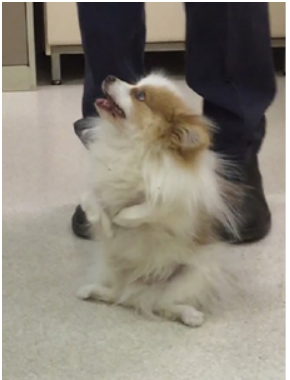
Figure 1: Six-month-old Pomeranian presenting with flexion of thoracic limbs (Source: Photo taken by E Bester at Onderstepoort Veterinary Academic Hospital)